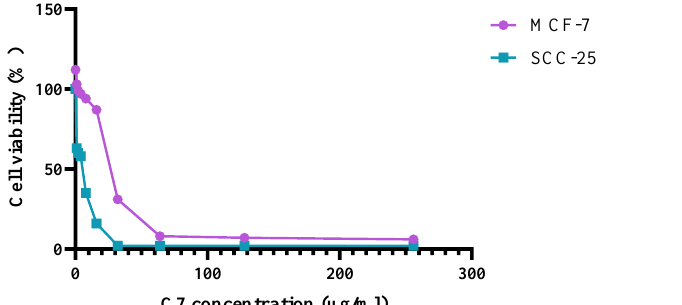
Figure 9. Effect of C7 on human breast cancer (MCF-7) and human skin cancer (SCC-25) cells.